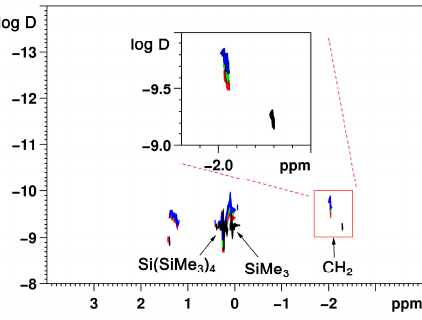
Figure 1. 1 H DOSY spectra of (NaCH(SiMe 3 ) 2 , 2 , 0.1 mol/L—green, 0.2 mol/L—red, 0.3 mol/L—blue and LiCH(SiMe 3 ) 2 , 1 , 0.079 mol/L—black) with the CH region magnified. Increasing the concentration of 1 (only the 0.079 mol/L concentration spectrum presented) hardly influences the diffusion